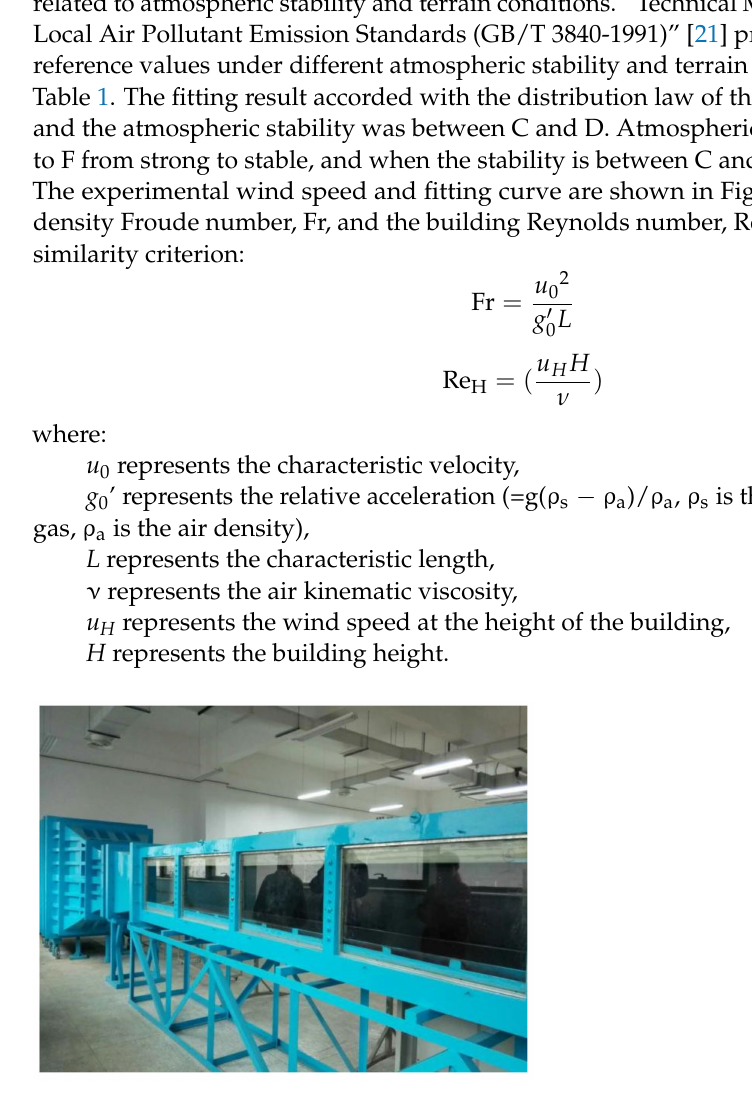
Figure 1. TULTWT DC wind tunnel. Table 1. Wind profile index α under different atmospheric stability